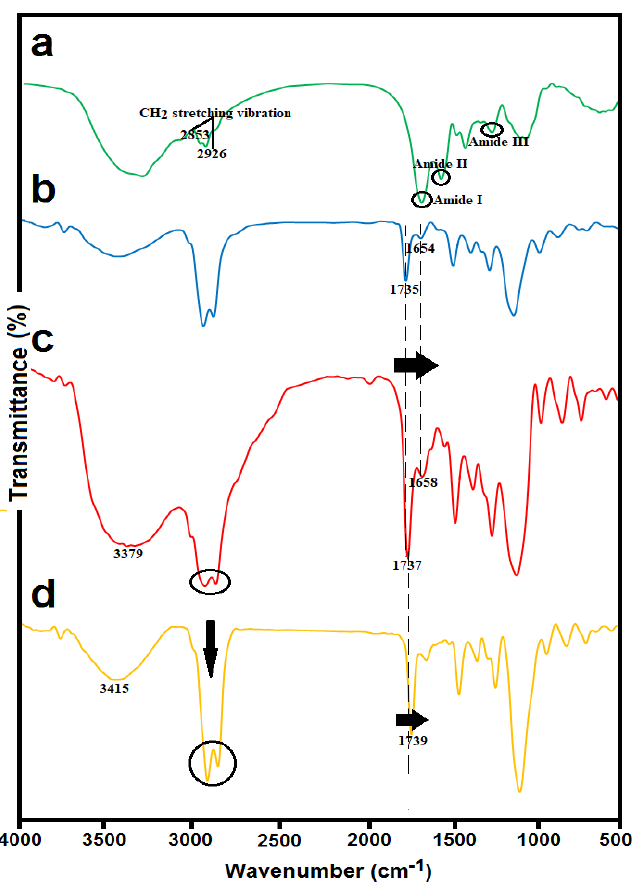
Figure 3. FTIR spectra of ( a ) Spirulina hydrolysate (HS); ( b ) blank nanoliposomes stabilized with γ -oryzanol; ( c ) HS-loaded γ -oryzanol nanoliposomes; and ( d ) HS-loaded γ -oryzanol-chitosomes.